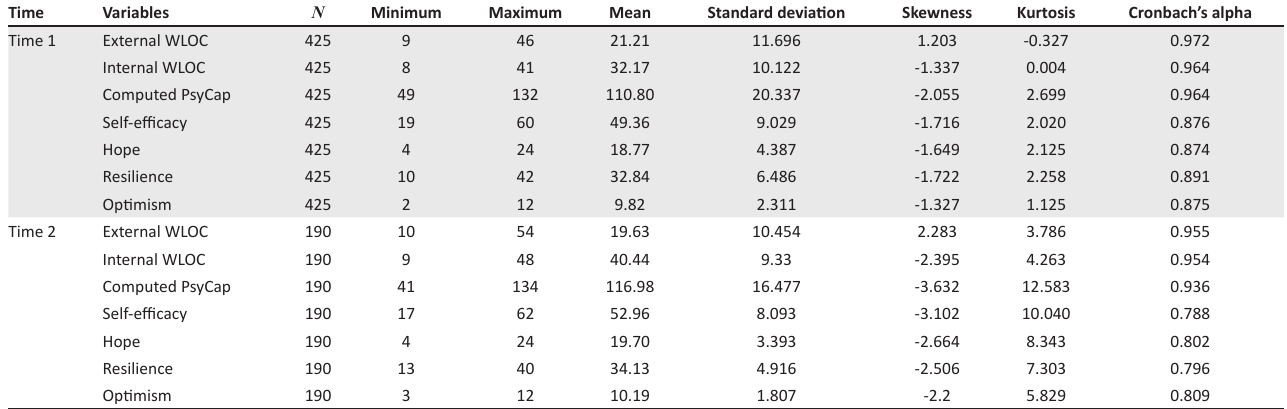
TABLE 2: Descriptive